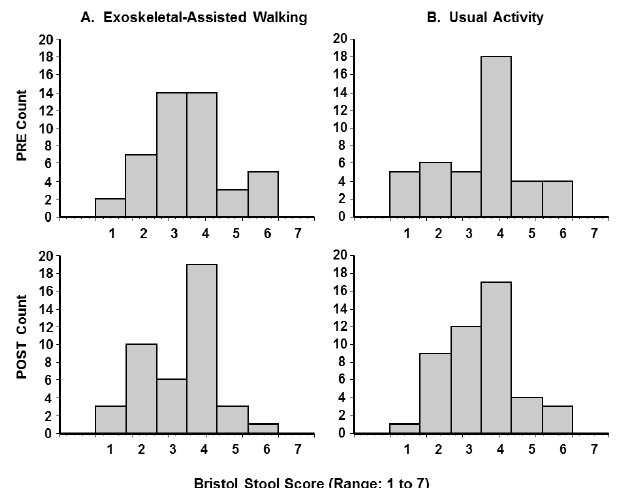
Figure 1. Bristol Stool Form Scale (BSS) results. Frequency distribution of pre- and post-exoskeletal-assisted walking and pre- and post-usual activity. The top row represents preintervention, and the bottom row, postintervention data. Larger values on the 1 to 7 BSS represent looser stools. Details of the BSS can be found in the Appendix A.